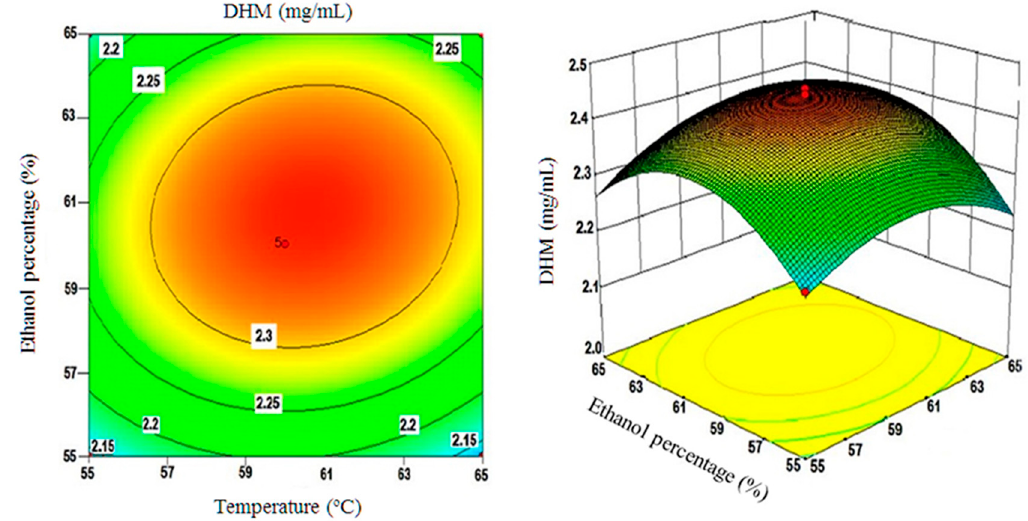
Figure 6. A 3D surface plot of ethanol (%) and extraction temperature(s) interactions and their effect on DHM yields